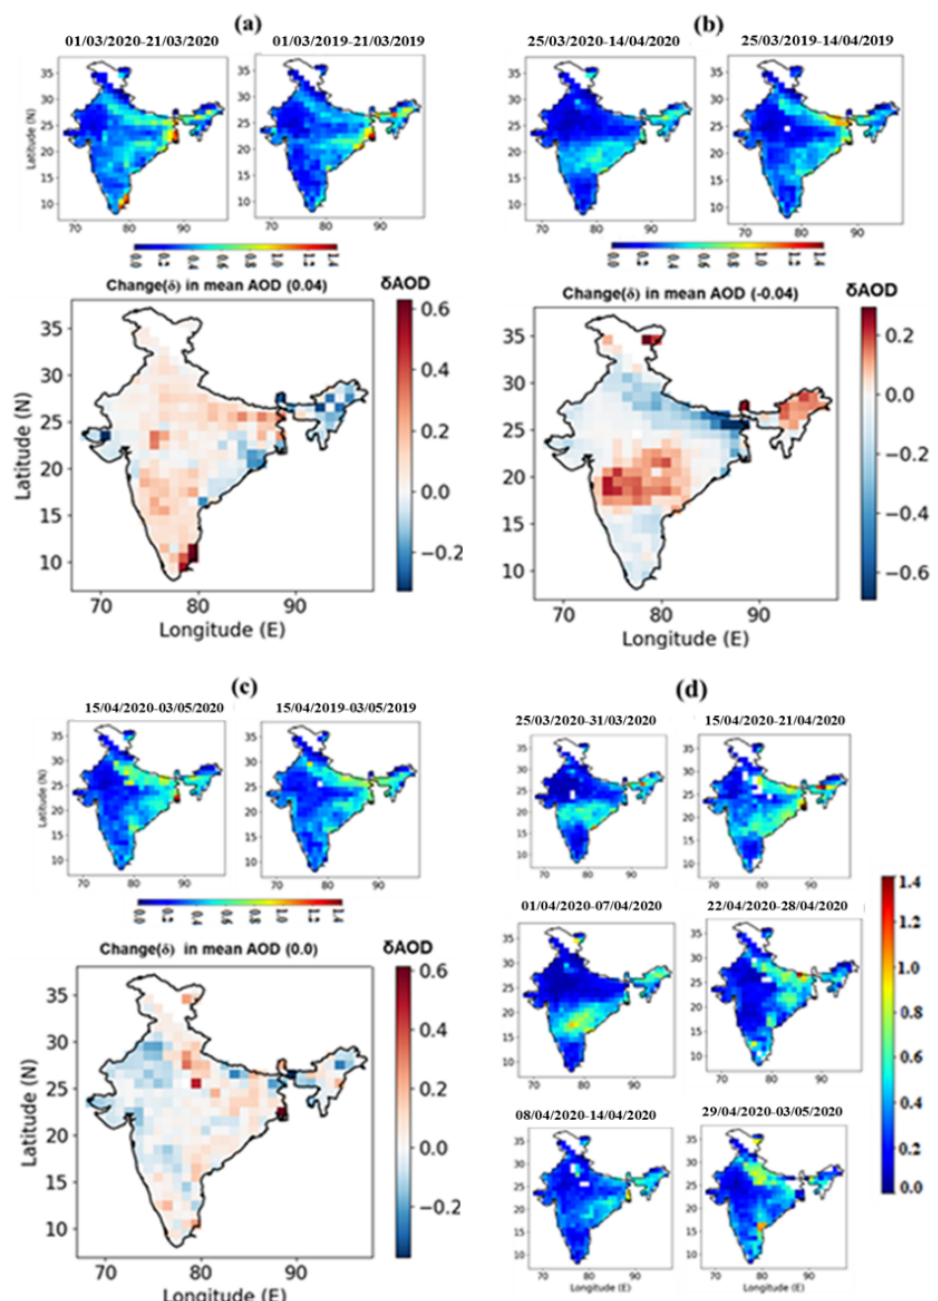
Figure 6. Aqua MODIS-derived time-averaged AOD 550 and its difference maps in 2020 and 2019 (a) pre-LD, (b) phase I lockdown, and (c) phase II lockdown. (d) Weekly variation in total lockdown period during